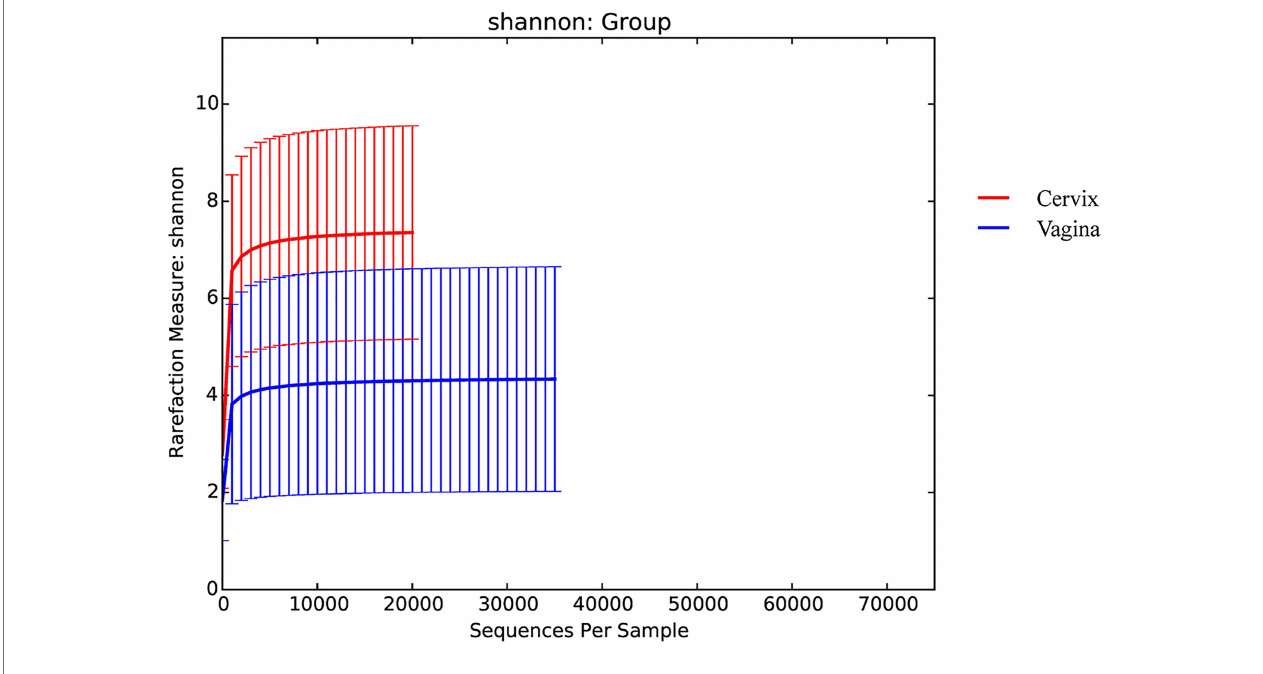
FIGURE 1 | Rarefaction curves for the Shannon index for each group.